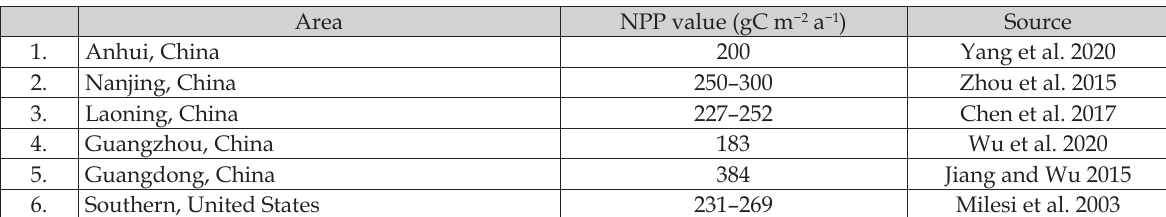
Table 5. Comparison of net primary productivity (NPP) in several urban